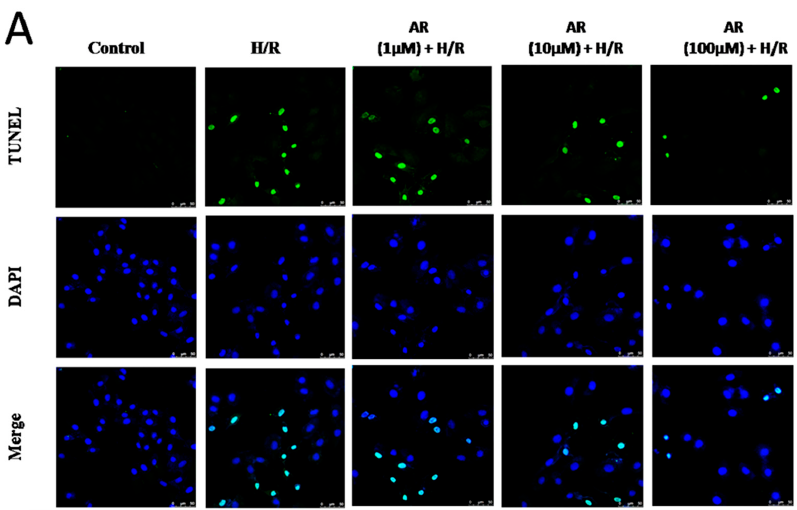
Figure 4 . Cont . Figure 4.